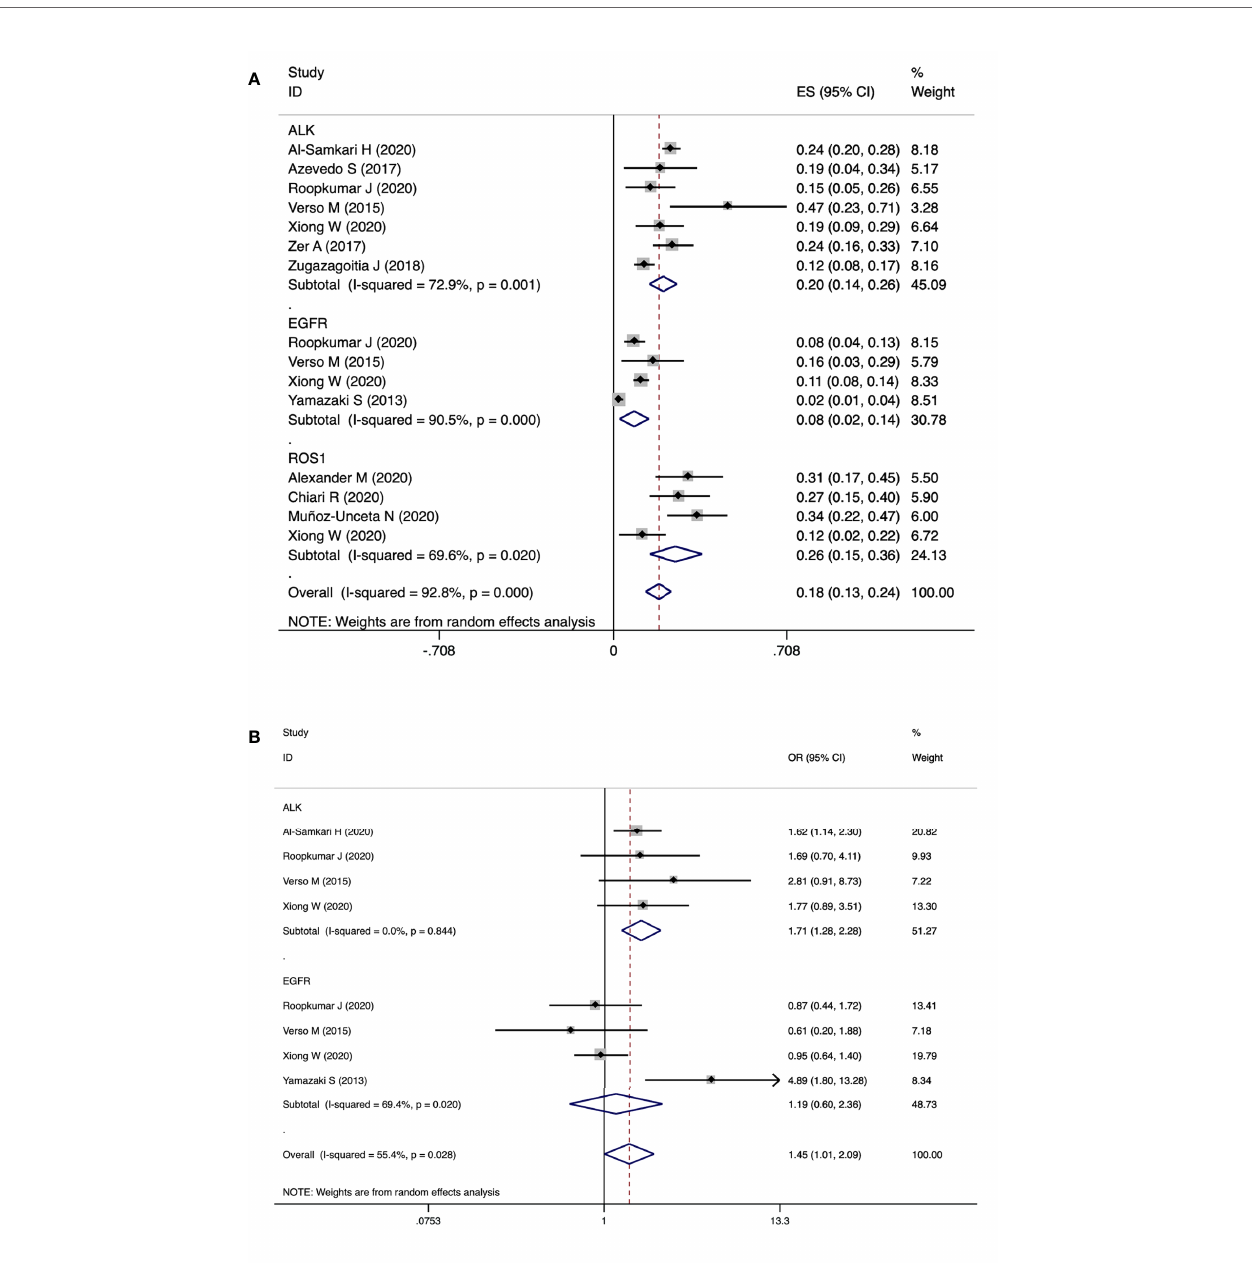
FIGURE 6 | The association of driver genes with PE events. (A) Pooled estimates for incidence of PE in patients with EGFR mutation, ALK rearrangement and ROS1 rearrangement. (B) Forest plot demonstrating the association of driver genes with PE